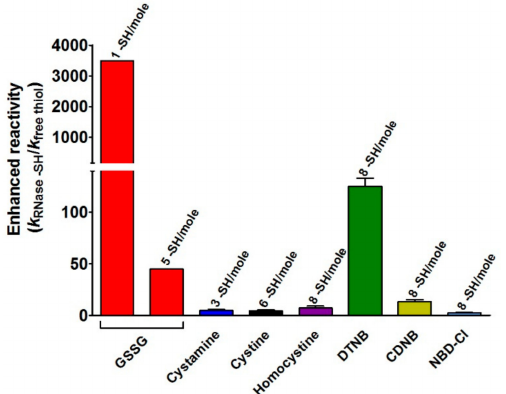
Figure 2. Reactivity of protein cysteines toward disulfides and thiol reagents normalized to that of GSH and free Cys. Second-order kinetic constants of the rRNase toward GSSG (red bars) normalized to the constant calculated for an unperturbed protein cysteine (0.2 M − 1 s − 1 ) (see Materials and Methods) represent the “enhanced reactivity”. All other bars represent the second-order kinetic constants of the rRNase in its reactions with other disulfides and thiol reagents normalized to the constants for free GSH. Error bars represent the propagation of uncertainties for the quotients [20] (see Materials and Methods).